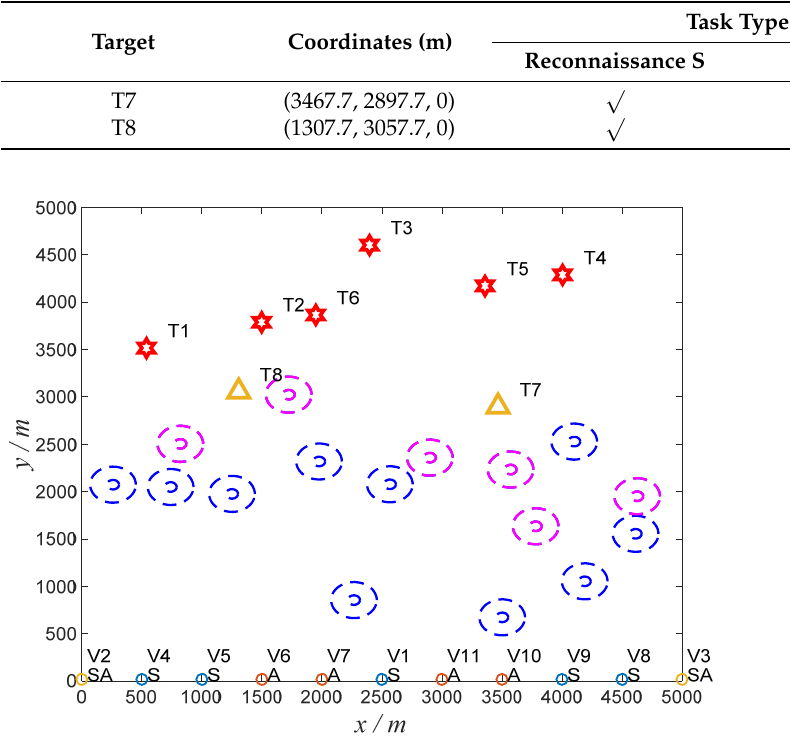
Figure 12. The initial setting of the situation between both sides. (Considering unknowned targets).